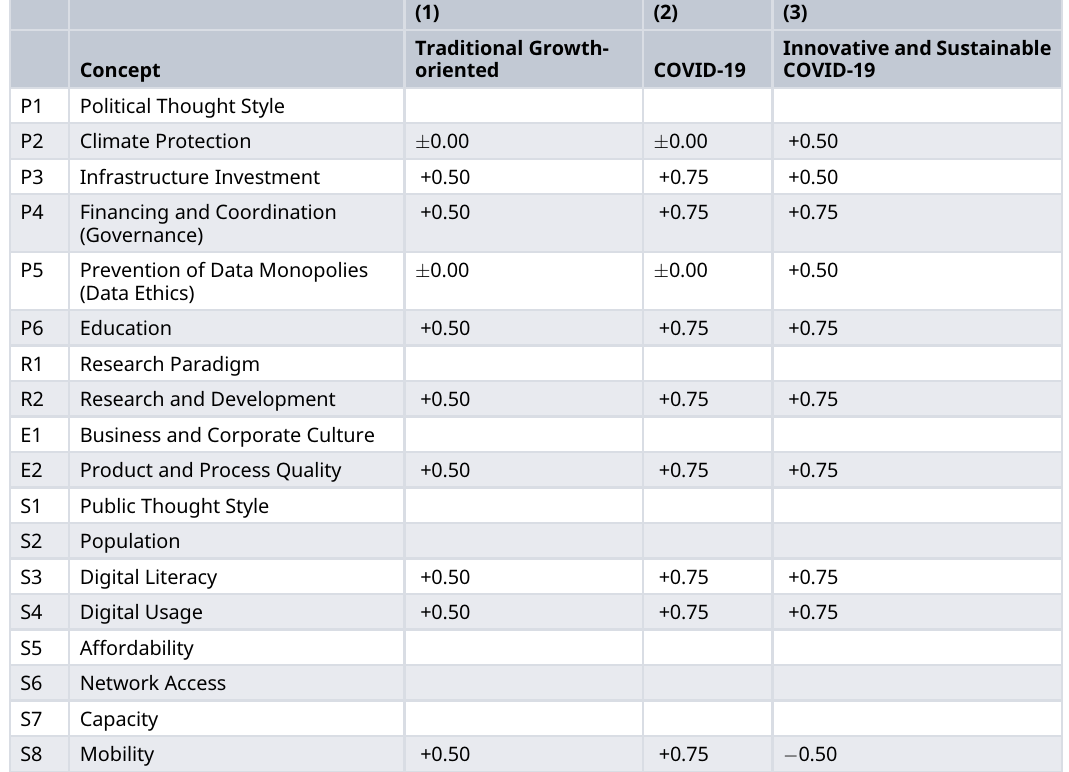
Table 12. State vectors related to the three alternative